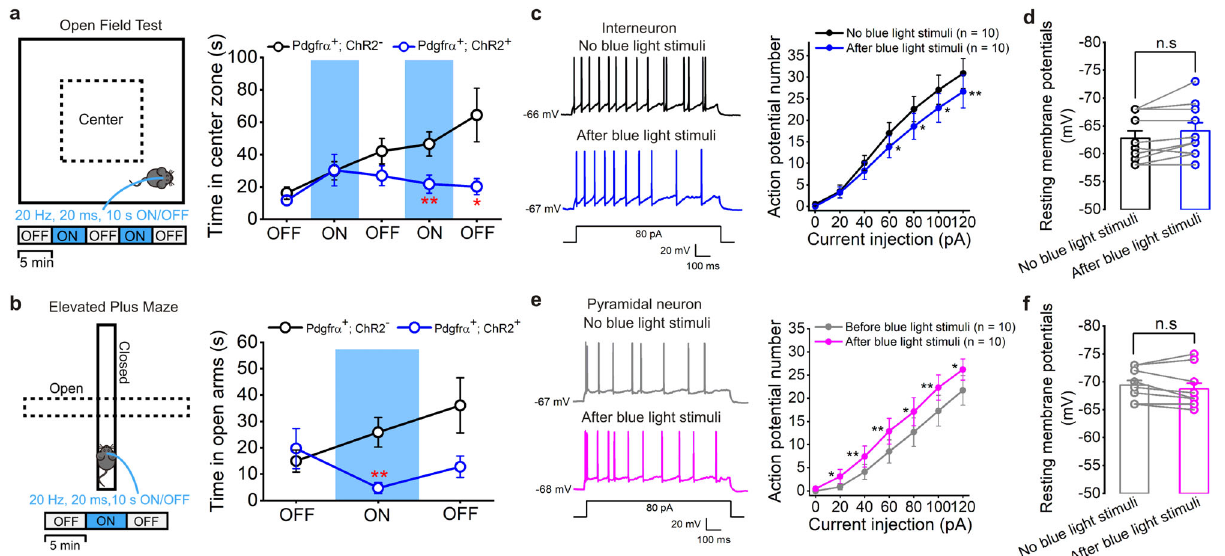
Fig. 7 NG2 glia photoactivation triggers an anxiety-like behavior through an E-I balance perturbation in adult mice. a Cartoon illustrating the procedure for intermittent photoactivation of ChR2-expressing NG2 glia in the adult hippocampus at postnatal 8 – 12 weeks in an open fi eld test. Pdgfr α -creER + ; ChR2 − mice as its negative control. The right panel shows an average time in the center zone traveled by the mice over 25 min, including blue light stimulations (20 Hz, 20 msec, 10 s ON/OFF) in an open fi eld chamber, divided into 5-min epochs for the two experimental groups. Time in center zone: